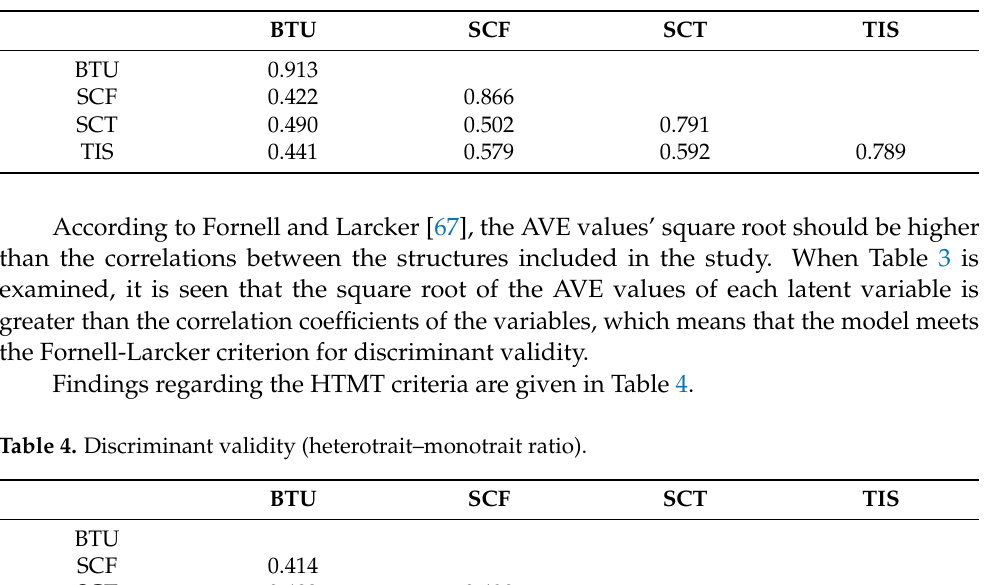
Table 3. Discriminant validity (Fornell and Larcker criteria).